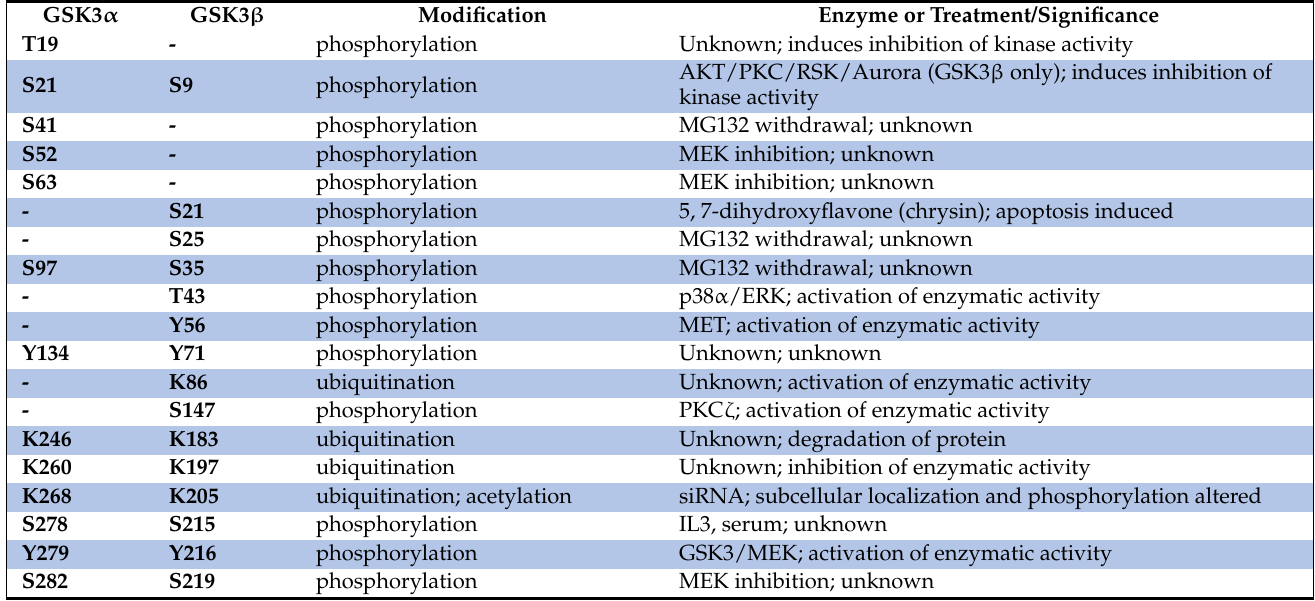
Table 2. A list of GSK3 α / β post-translational modification sites with known modifiers, consequences or significant homology between